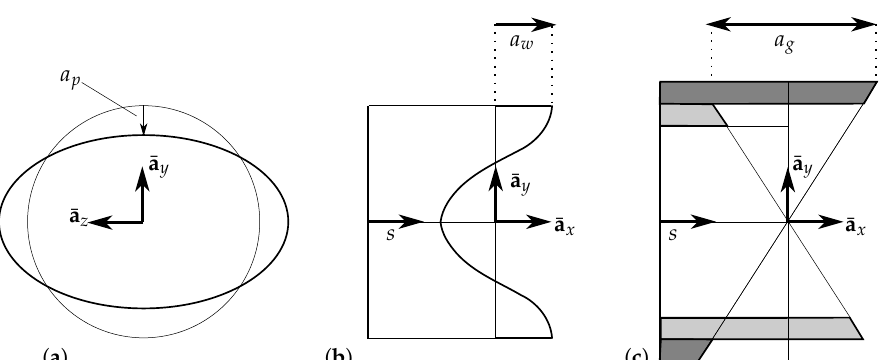
Figure 2. Initial configuration of the beam.